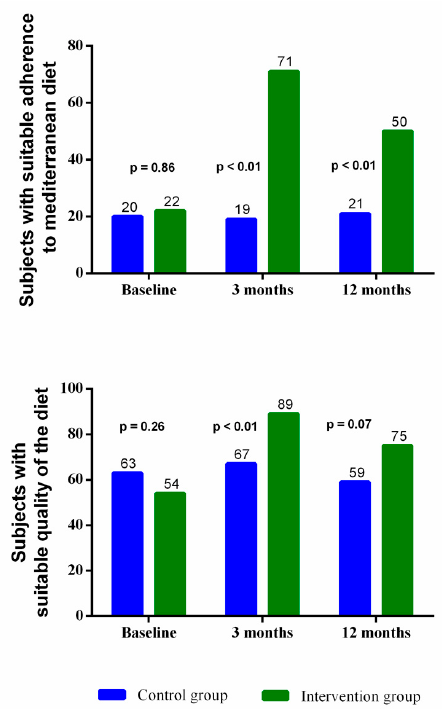
Figure 2. Changes in the number of subjects with suitable adherence to the Mediterranean diet and quality of diet. The chi-squared test or Fisher exact test was carried out.